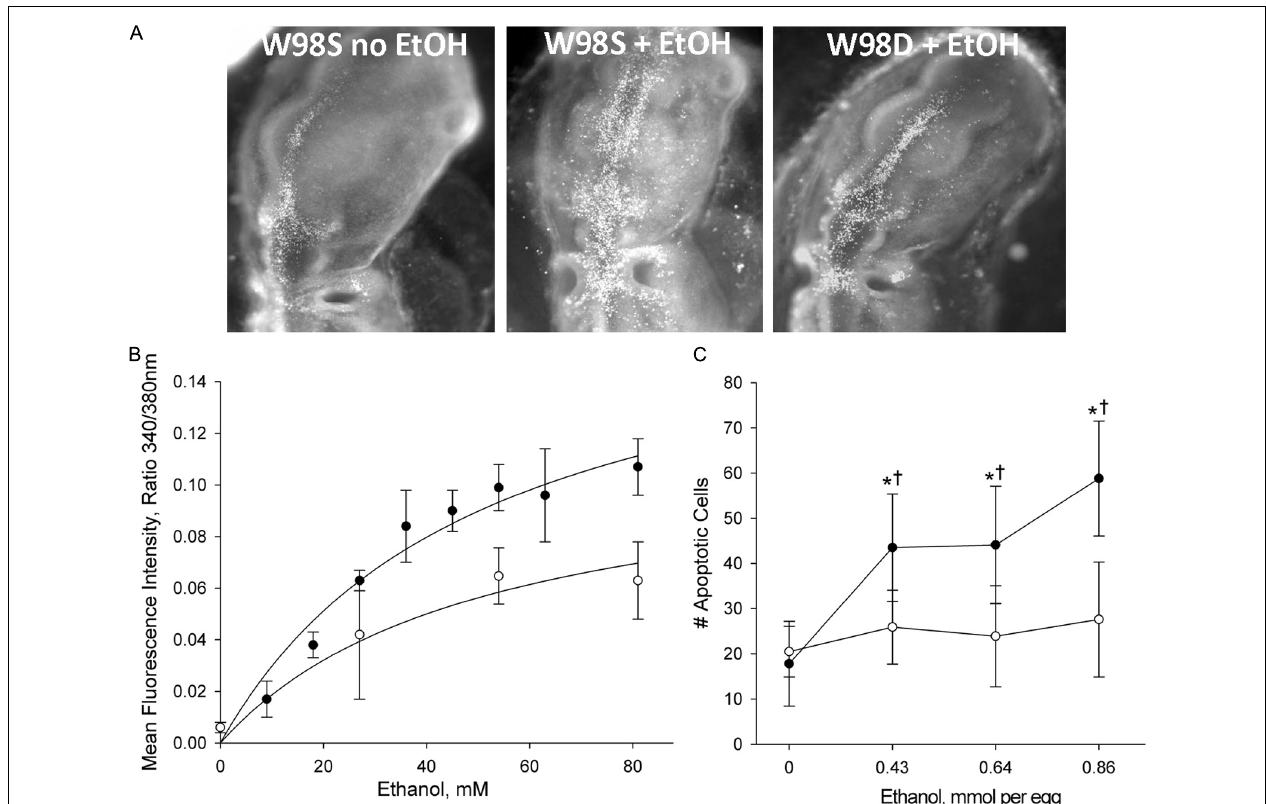
FIGURE 3 | Chick lines of the W98 background differ in their sensitivity to ethanol-induced apoptosis. (A) There is appreciably more ethanol-induced cell death (white dots) in neural crest and neuroprogenitors in line W98S as compared with ethanol-treated W98D. Cell death levels in the latter do not differ from that in saline-treated controls. Here, cell death is visualized using acridine orange, which detects apoptosis in this model; dorsal view is shown. (B) W98S embryos ( • ) mobilize greater intracellular